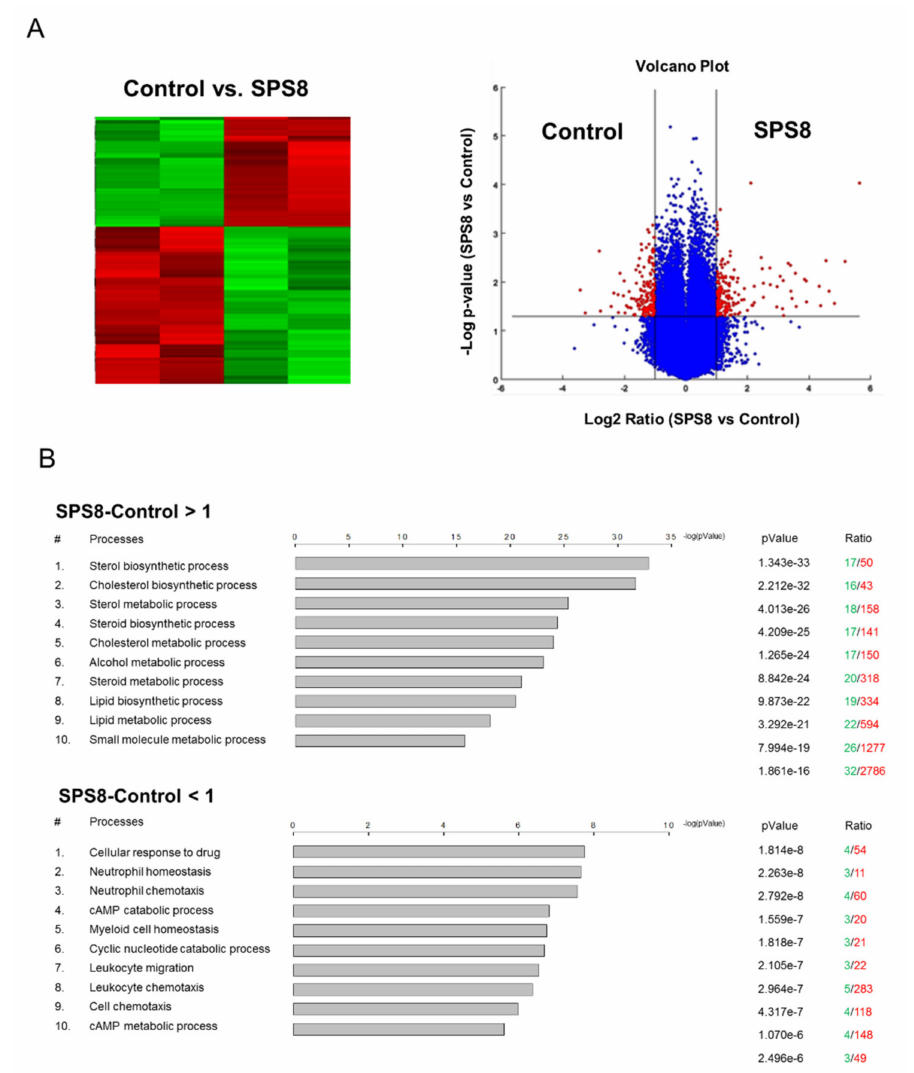
Figure 5. Di ff erentially expressed genes and pathways deregulated in HL-60 cells treated with SPS8. ( A ) A volcano plot and heat map of the expression profiles of genes deregulated in cells treated with SPS8 (5 µ M, 6 h), compared with untreated cells. Red denotes high expression; green indicates low expression. ( B ) List of pathways identified by the gene ontology (GO) enrichment analysis. Top 10 networks of up-regulated (SPS8-Control > 1) and down-regulated (SPS8-Control < 1) genes that were di ff erentially expressed in the cells treated with SPS8 compared to the